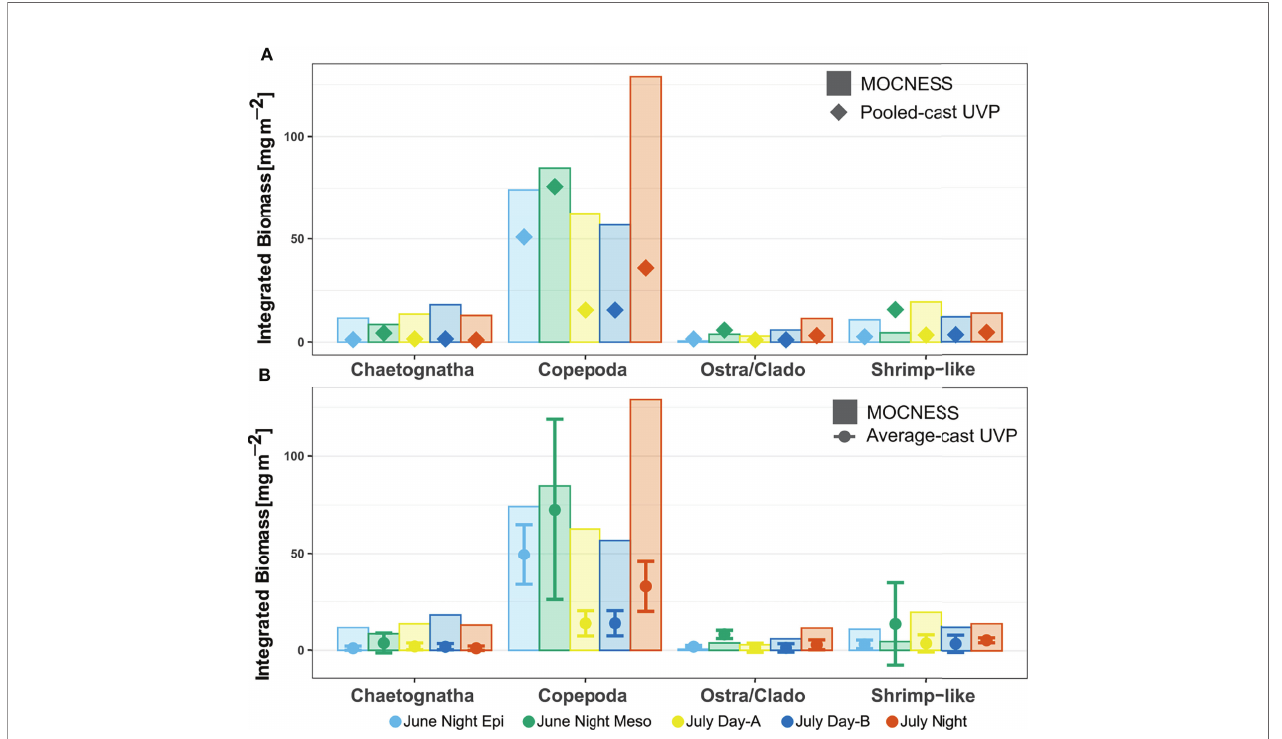
FIGURE 9 | Depth integrated biomass for each speci fi c taxon comparing estimates from MOCNESS to (A) pooled-cast UVP calculations and to (B) average-cast UVP calculations. Average-cast UVP calculations show standard deviation between similar UVP casts. There were no signi fi cant differences in the taxon-speci fi c estimated depth integrated biomass between MOCNESS to pooled-cast UVP, MOCNESS to average-cast UVP, nor pooled-cast to average-cast